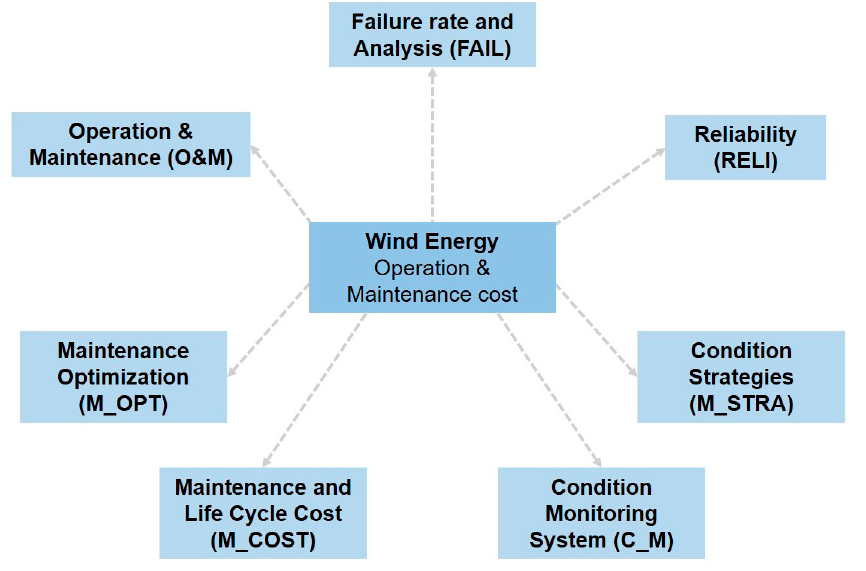
Figure 2. Outline of wind energy O&M cost fields. Table 2. Keywords grouped in the grouping